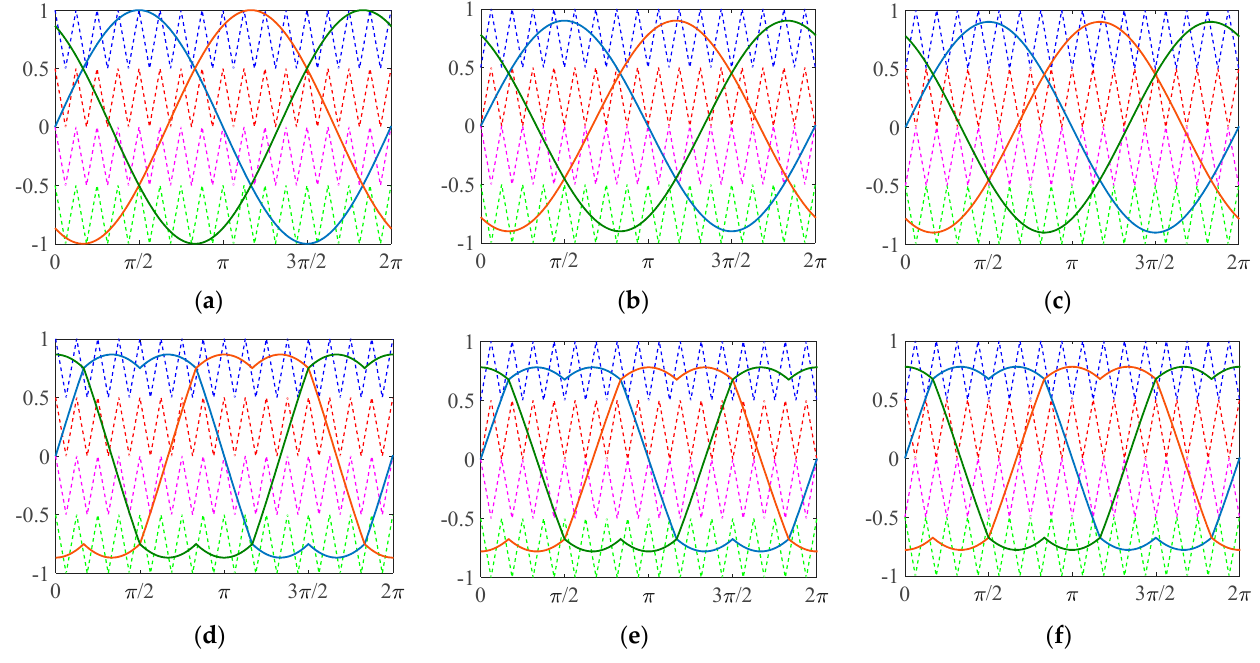
(d) Figure 6. Carrier ‐ disposition ‐ based modulation schemes: ( a ) Sinusoidal Phase Shifted—SPS; ( b ) Sinusoidal Suppressed Carrier Arrangement Modulation—SCAMOD; ( c ) Switching Frequency Optimal Phase Shifted—SFOPS; ( d ) Switching Frequency Optimal Suppressed Carrier Arrange ‐ ment Modulation—SFOSCAMOD. In the next section, a brief discussion regarding implementation issues and im ‐ provements to obtain high performance with minimal hardware resources is presented.